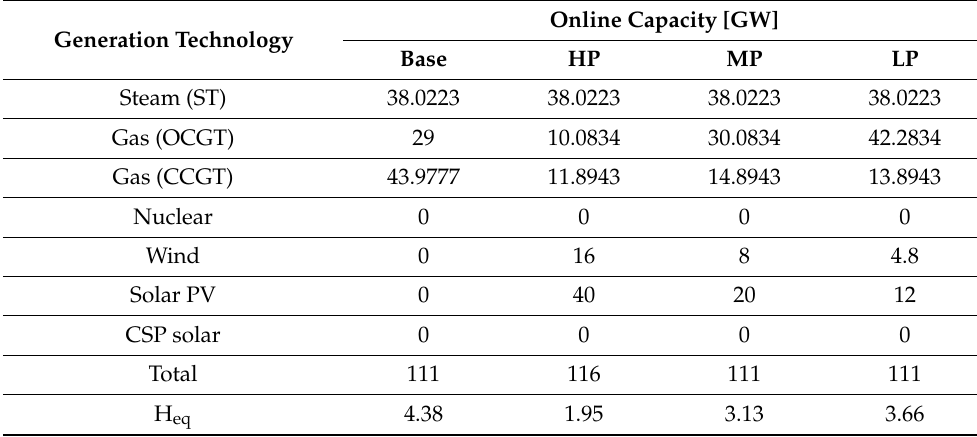
Table 7. Online generation capacity under peak load conditions in 2030.